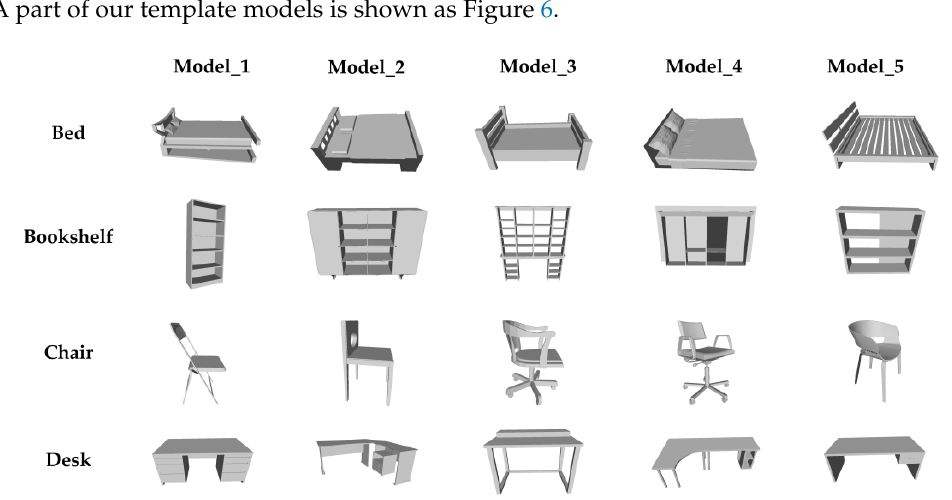
Figure 6. Several models of beds, bookcases, chairs, tables, etc. in the model